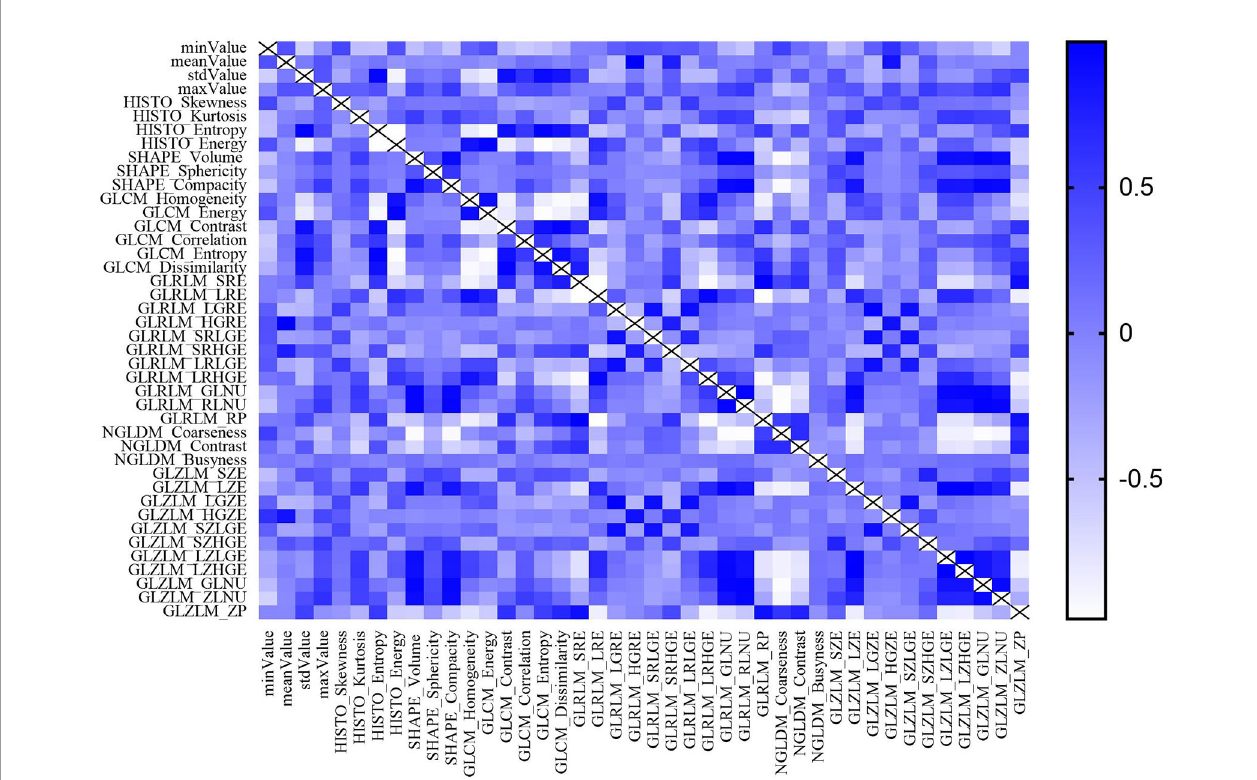
FIGURE 4 | The result of Pearson correlation coef fi cients test between radiomics